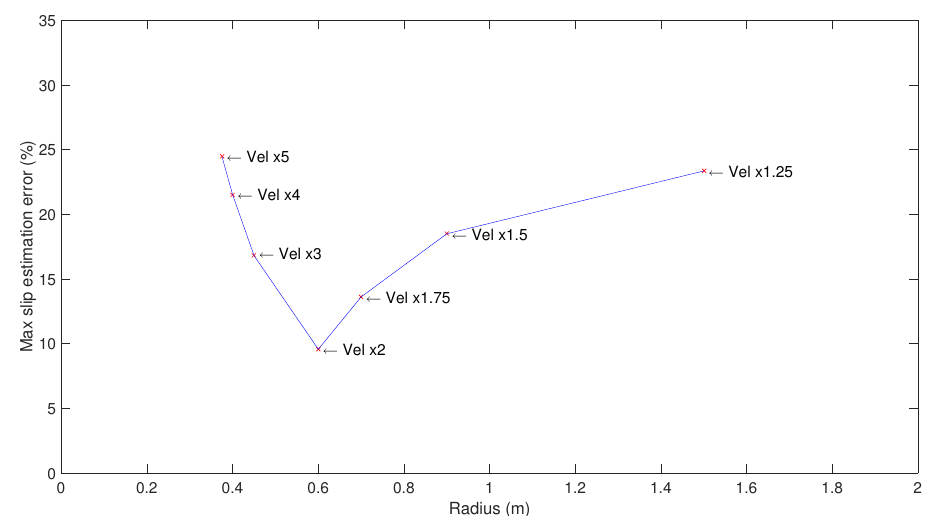
Figure 14. Representation of the parameters to be optimised, the maximum slip ratio and the rover turning radius due to the velocity increment. Based on it, the chosen velocity increment is